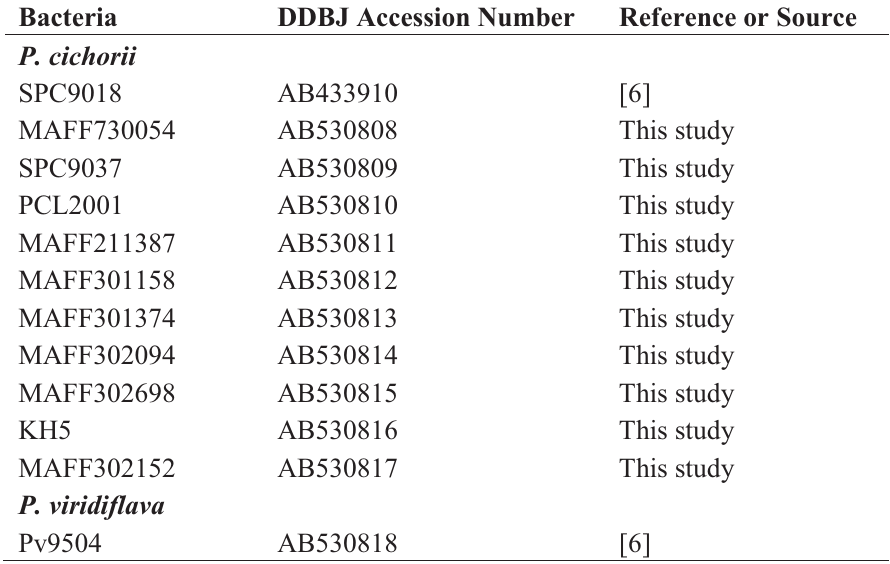
Table S1. List of bacteria analyzed and the accession numbers of the nucleotide sequences of aldH of bacteria deposited in the DDBJ/GenBank international nucleotide sequence